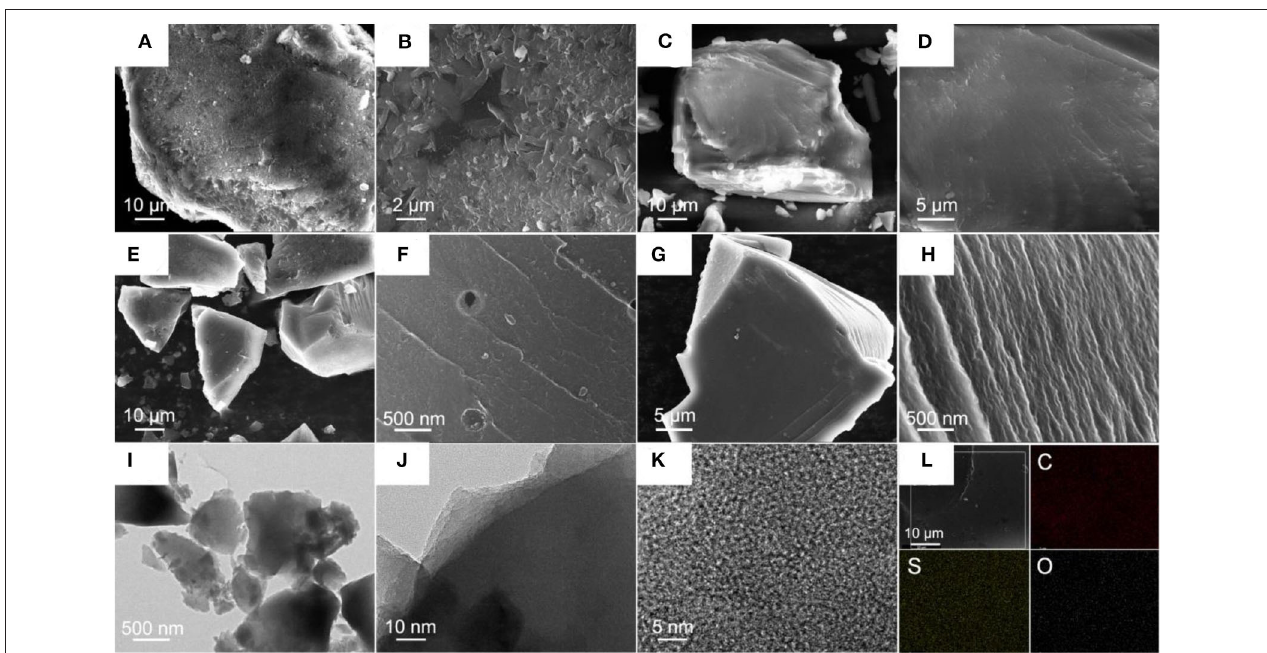
FIGURE 1 | SEM images for X-Na (A,B) , X-K (C,D) , C-Na (E,F) , and C-Cs (G,H) ; TEM images for C-Cs (I – K) ; EDS mapping (L) for C-Cs.